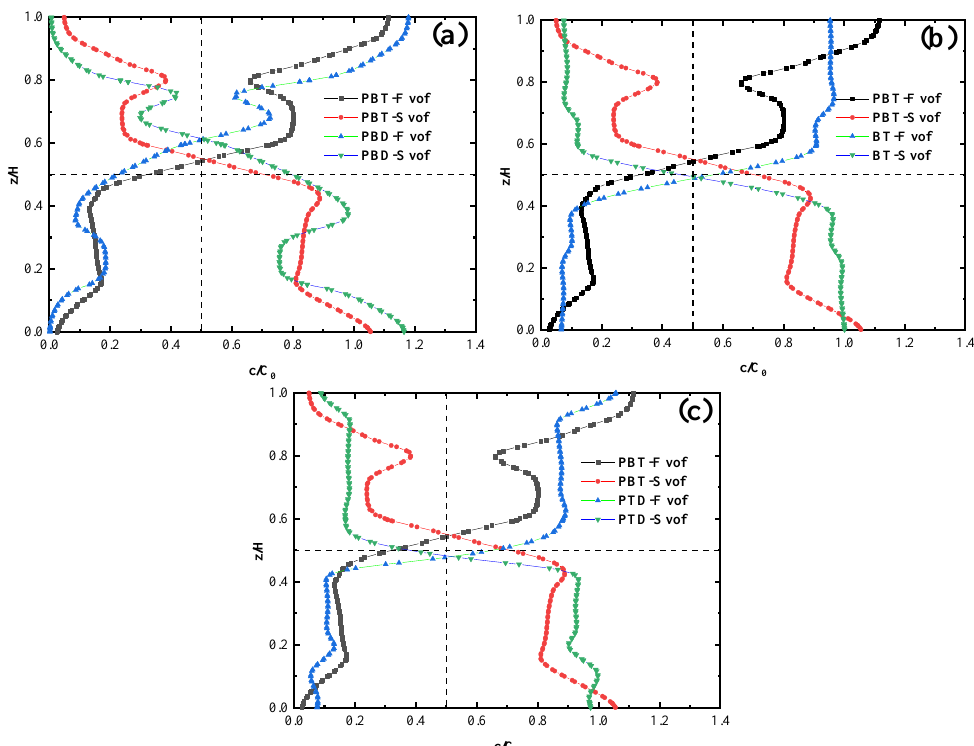
Figure 4. Comparison of normalized axial concentration of SP and FP for four blades (A = 0.6 D, B = 0.3 HL, C = 0.2 T): ( a ) PBT–PBD, ( b ) PBT–BT, and ( c ) PBT–HBT.